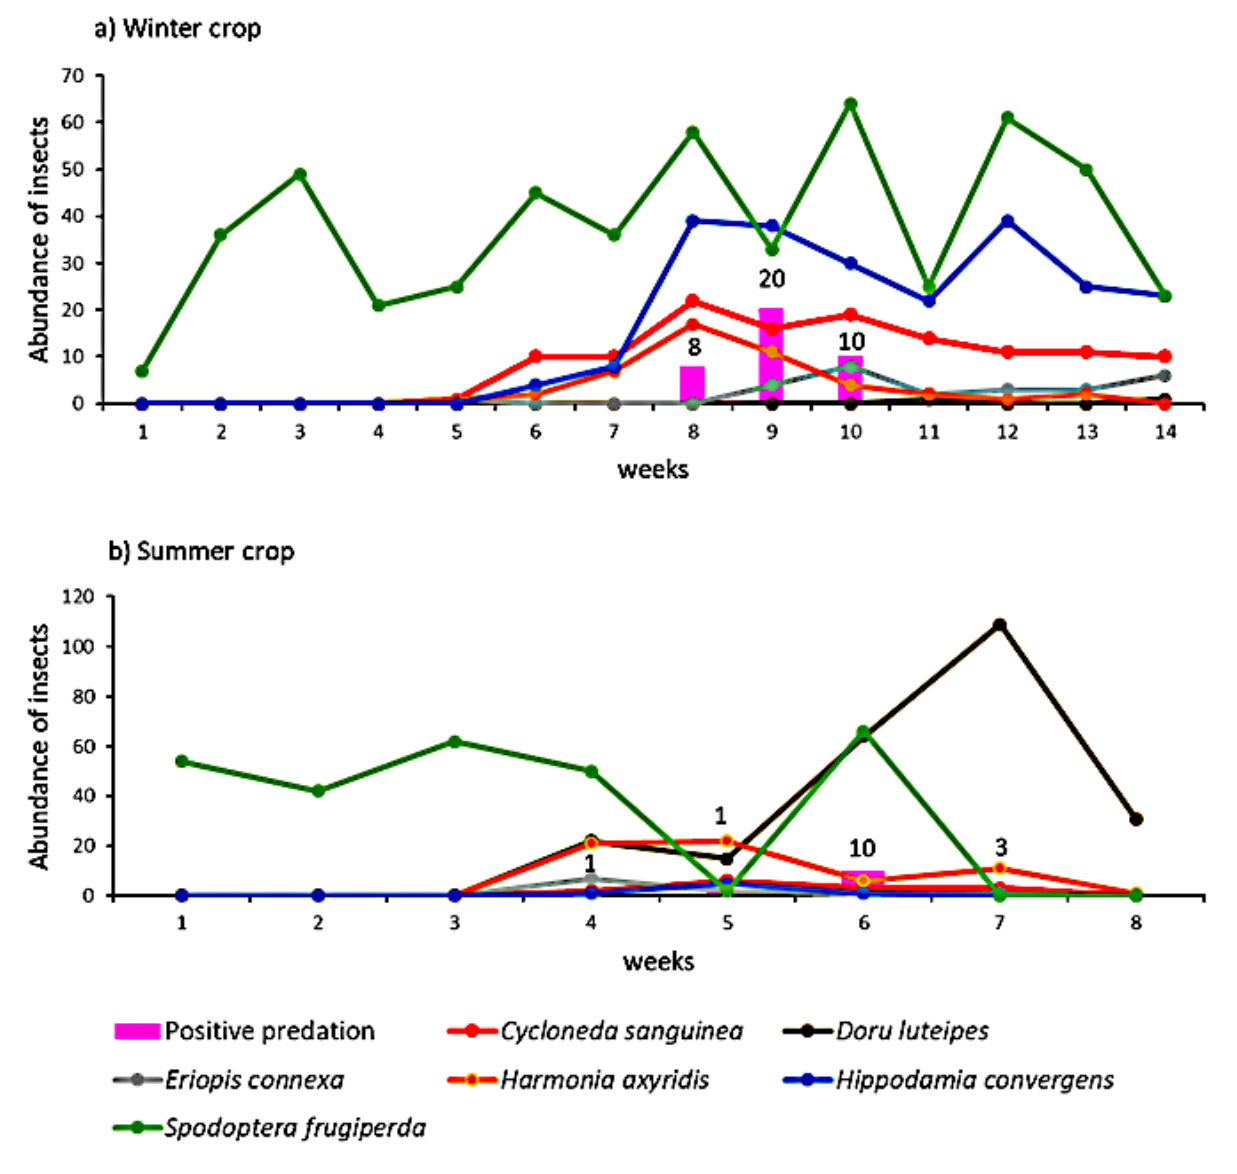
Figure 3. Total number of individuals of Doru luteipes, Hippodamia convergens, Harmonia axyridis, Cycloneda sanguinea, and Eriopis connexa sampled per week in Pirassununga during ( a ) winter crop (April to July 2020) and ( b ) summer crop (December 2020 to February 2021). Pink bars and the numbers on the top of the bars represent the total predation events identified as a positive result in PCRs from the field samples per week. The lines with dots represent the predator species sampled per week in the field.